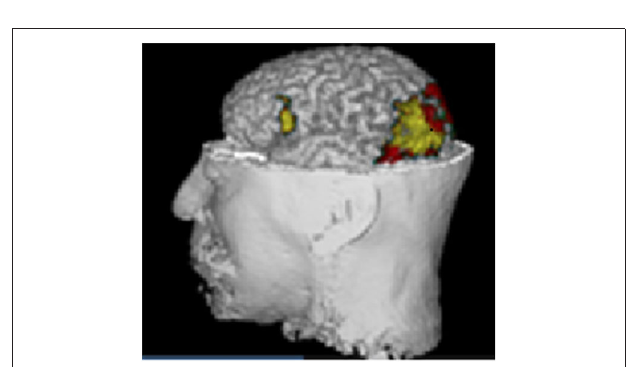
FIGURE 5 | Morphometric analysis of the T1 MRI of the same case. Statistical parametric mapping using the plugin IBASPM based on the regional volume of the MRI in comparison with the normative data (Z values). The yellow area identified the regions with brain damage, occipital damage responsible of visual impairment, and lesion in Broca’s area which explained the language impairment, not detected by MRI. The correspondence with Figure 4 is